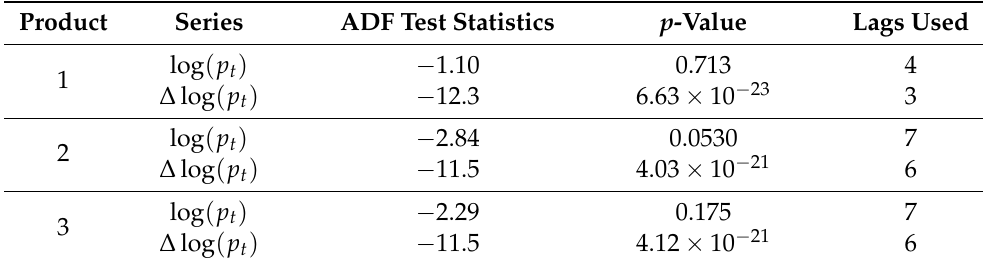
Table 3. Results of the augmented Dikey–Fuller